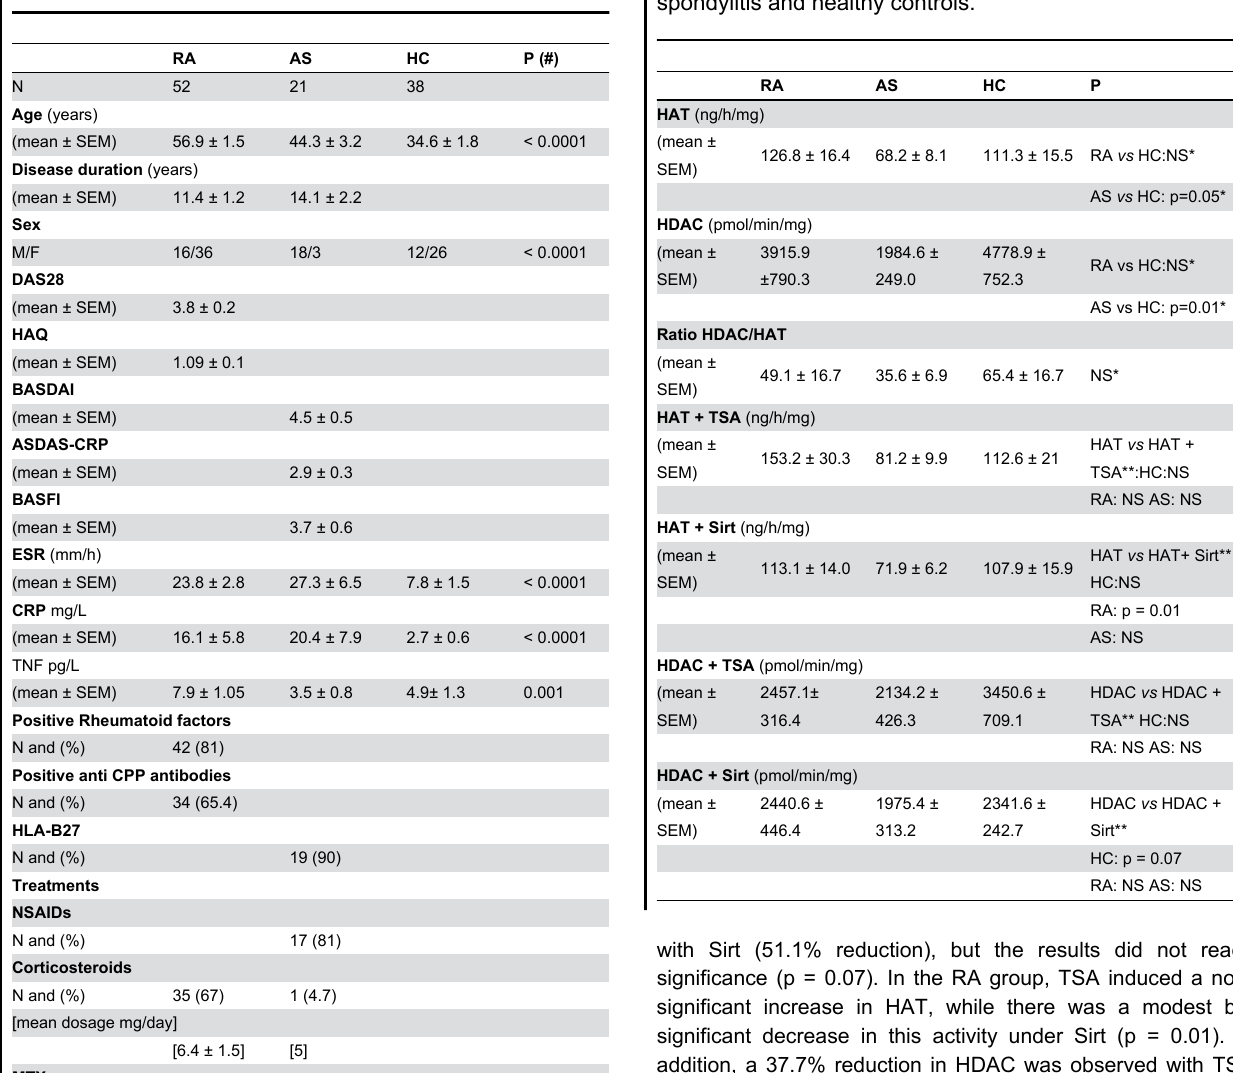
Table 1. Clinical and laboratory characteristics of the studied patients with rheumatoid arthritis, ankylosing spondylitis and healthy controls.